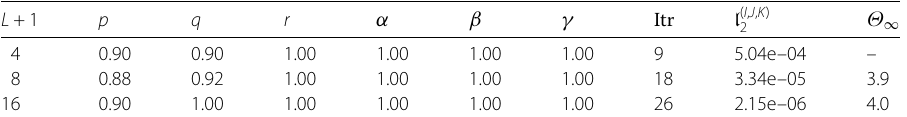
Table 5c Errors and order for EF-EEG-TOCS in Example 5.5 at (cid:2) = 0.1